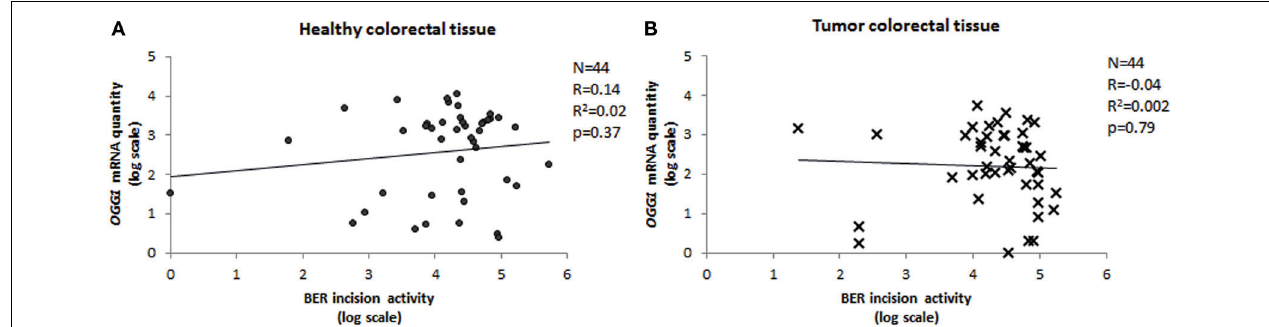
FIGURE 6 | Correlation between OGG1 expression and BER incision activity. Relative quantity of OGG1 transcripts measured in 44 paired healthy (A) and tumor (B) tissue samples plotted against BER activity (Pearson’s correlation coefficient).